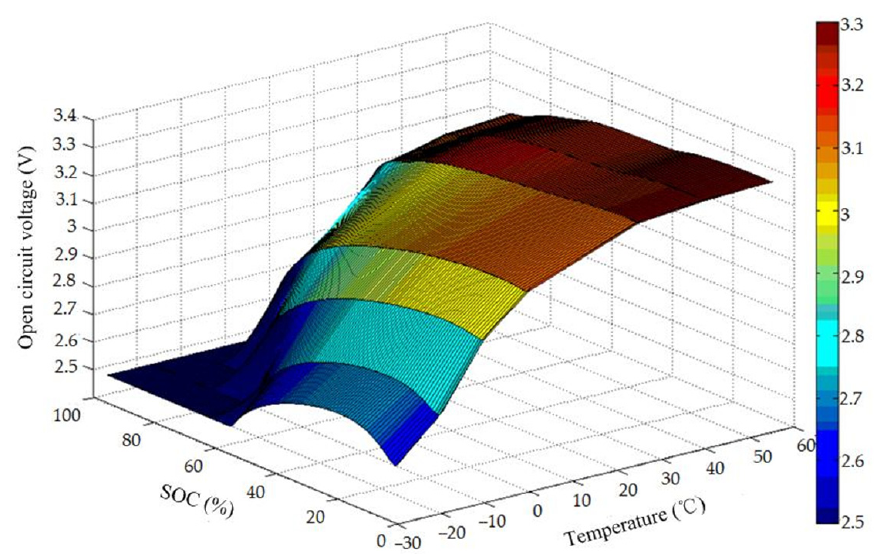
Figure 3. Three-dimensional map of Temperature-SOC-OCV.